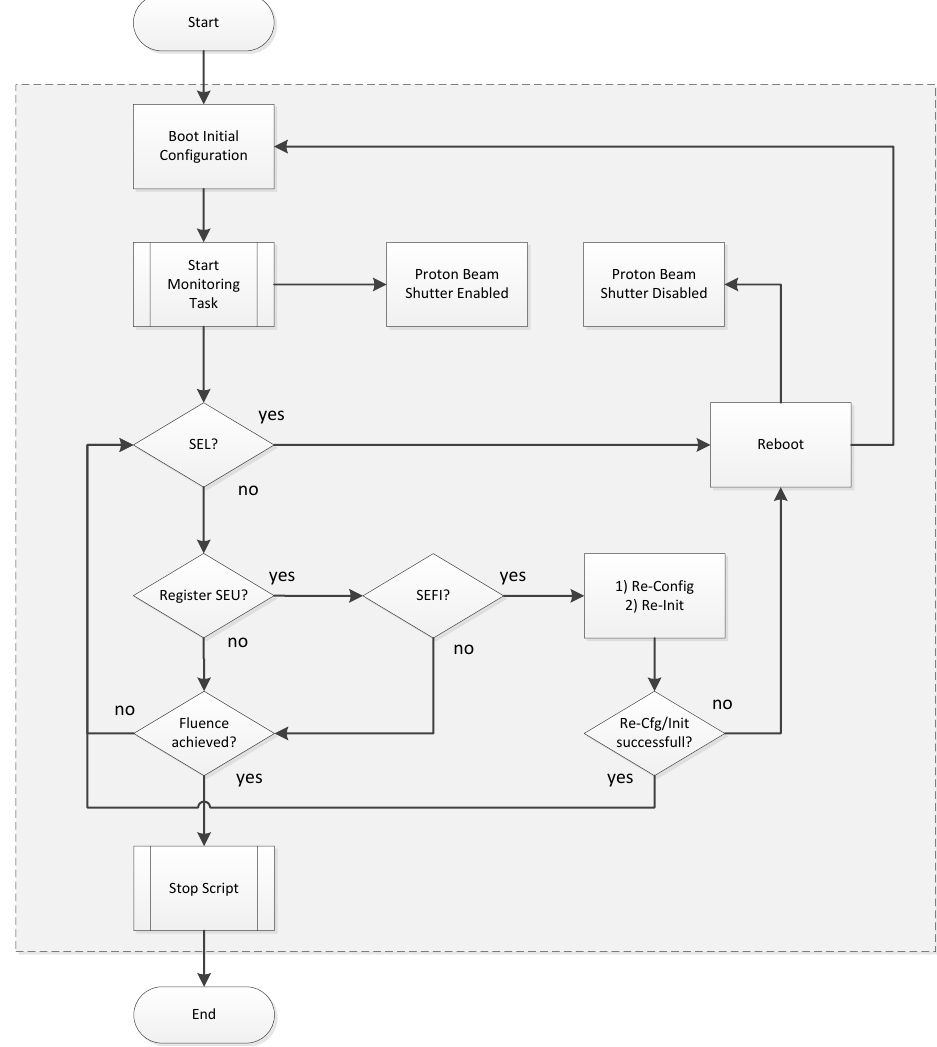
Figure 6. SEE test procedure flow